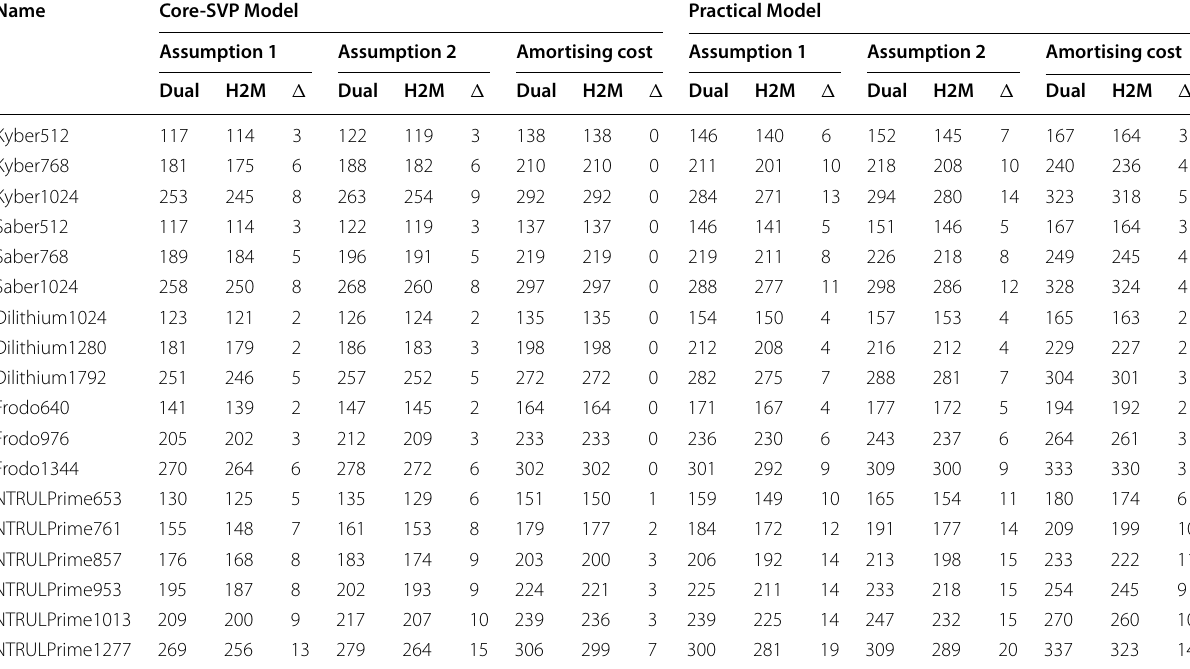
Table 12 Bit-security estimations under different cost models and assumptions